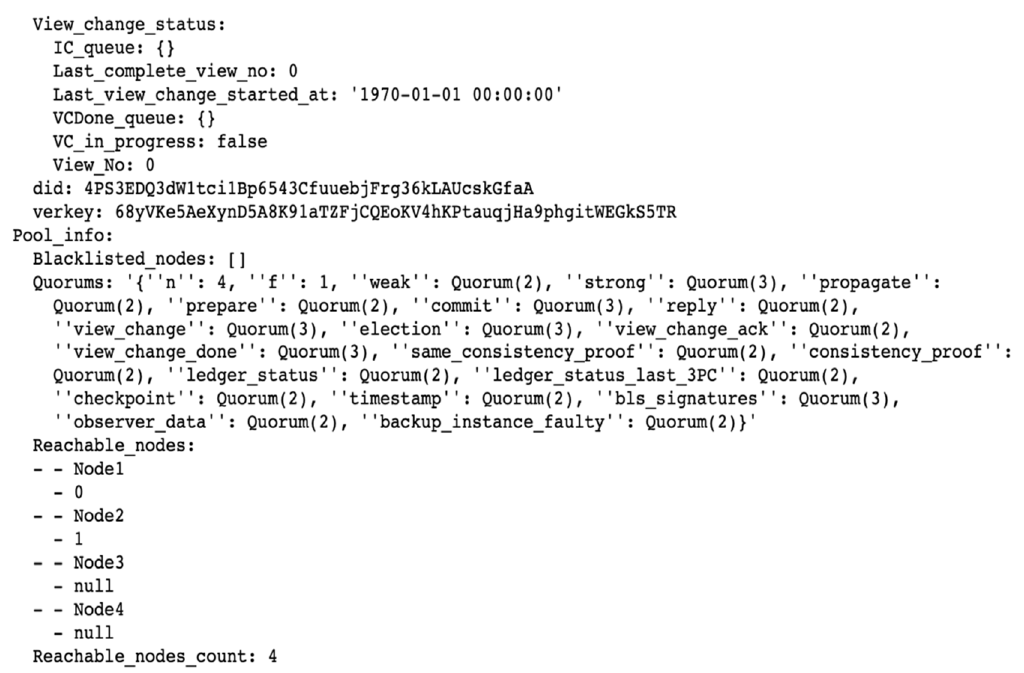
Figure 9. The result of consensus of transaction which is stored in their ledgers in nodes.